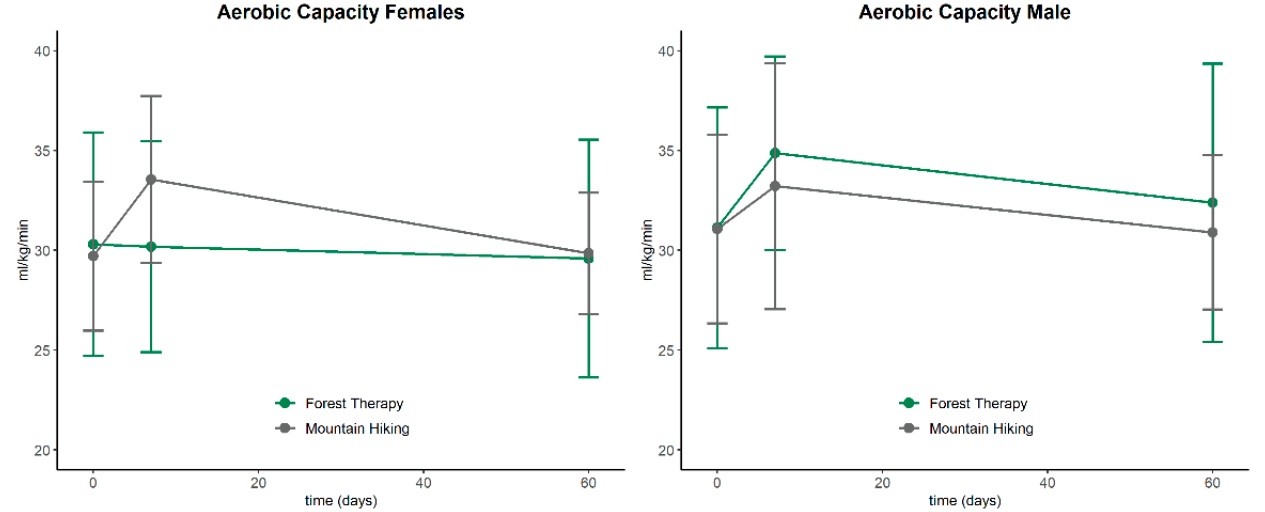
Figure 3. Mean ± standard deviation of aerobic capacity for the female and male subgroups on days 0, 7 and 60 (forest therapy vs. mountain hiking).